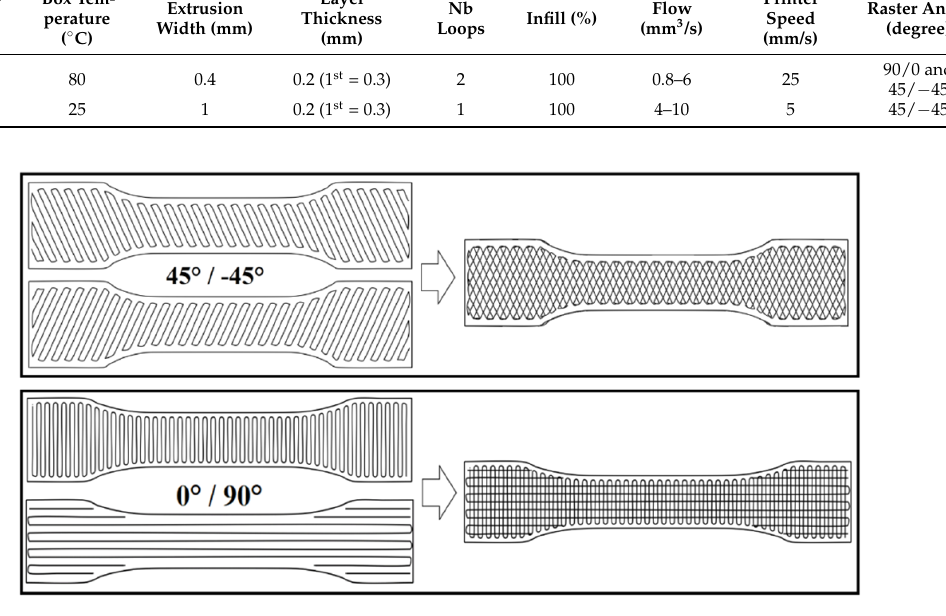
Figure 3. Schematic presentation of the raster angle 45°/ − 45° and 0°/90°used for the ABS-based samples 3D printing.